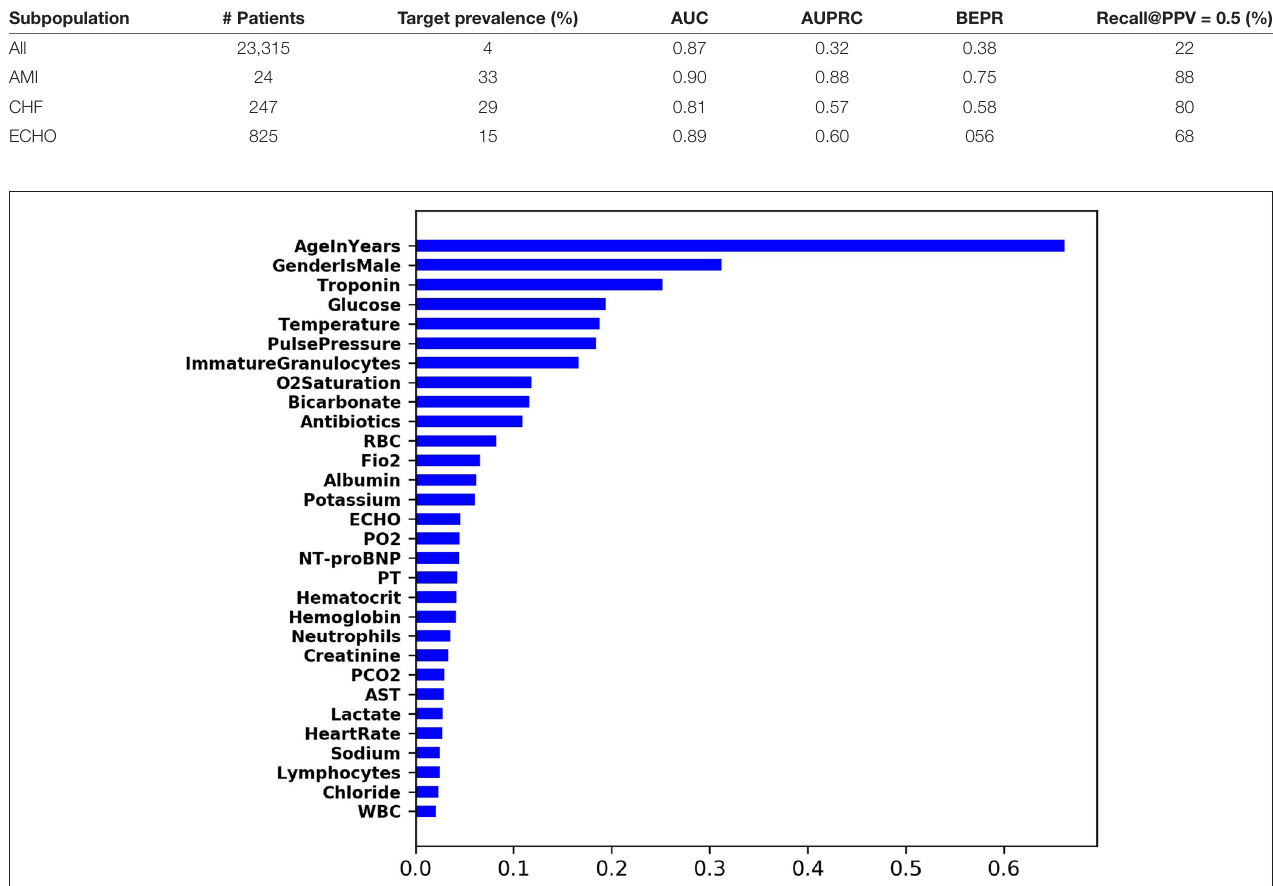
TABLE 9 | Model performance over four different subpopulations.